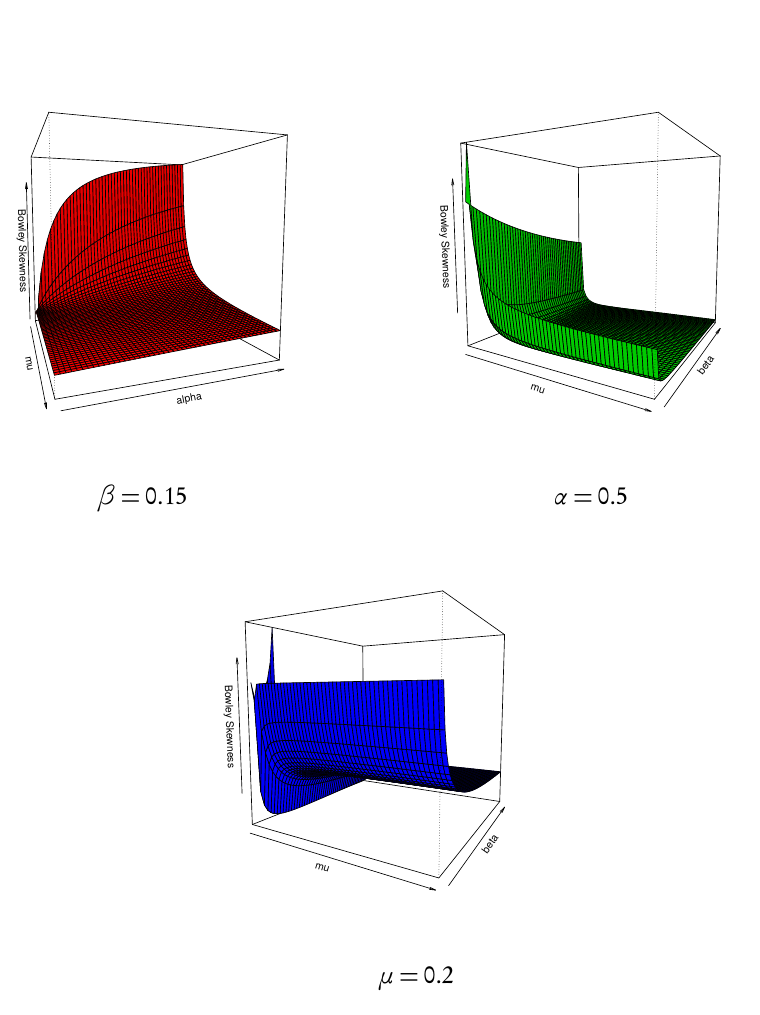
Figure 3 – The 3D plots of the Bowley’s